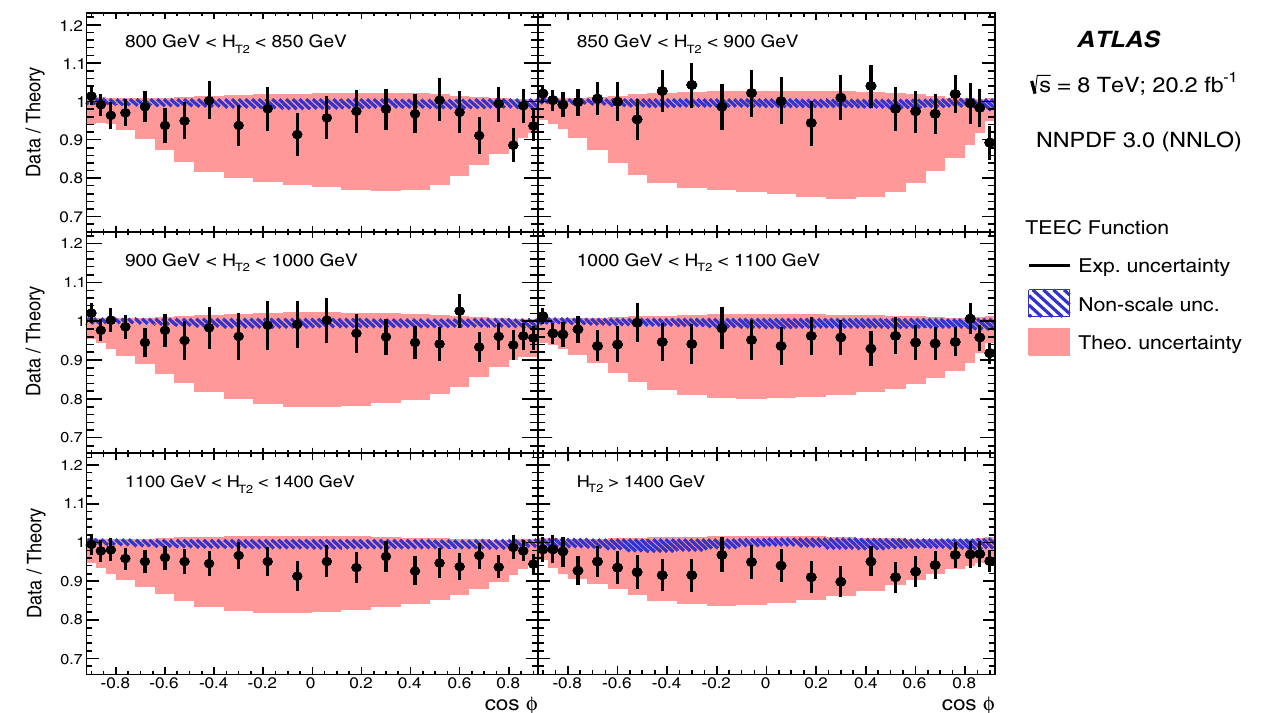
Fig. 6 Ratios of the TEEC data in each H T2 bin to the NLO pQCD predictions obtained using the NNPDF 3.0 parton distribution functions, and corrected for non-perturbative